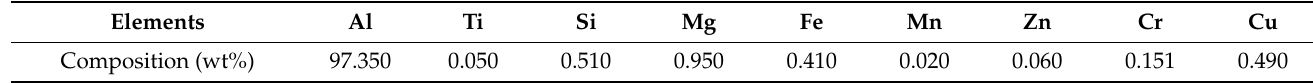
Table 2. Chemical composition of the alloy 6061.